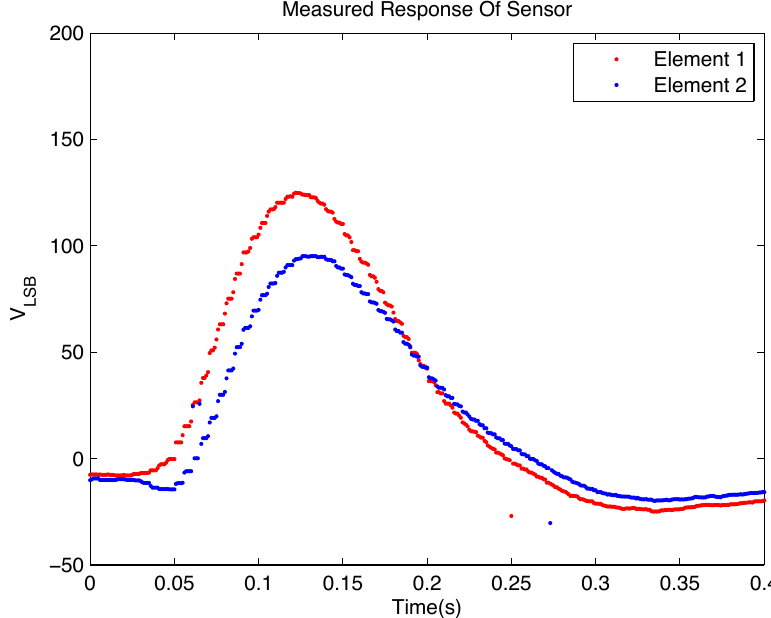
Figure 6. Mean digital response results of Element 1 and Element 2 for 5 N